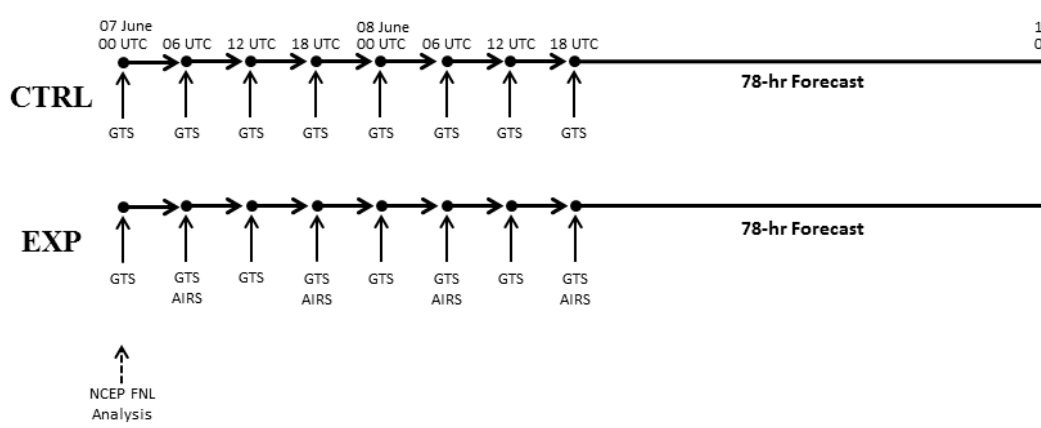
Figure 5. Schematic diagram of the experimental design illustrating an example data assimilation cycle and the 78-h forecast from 1800 UTC 8 June 2012.